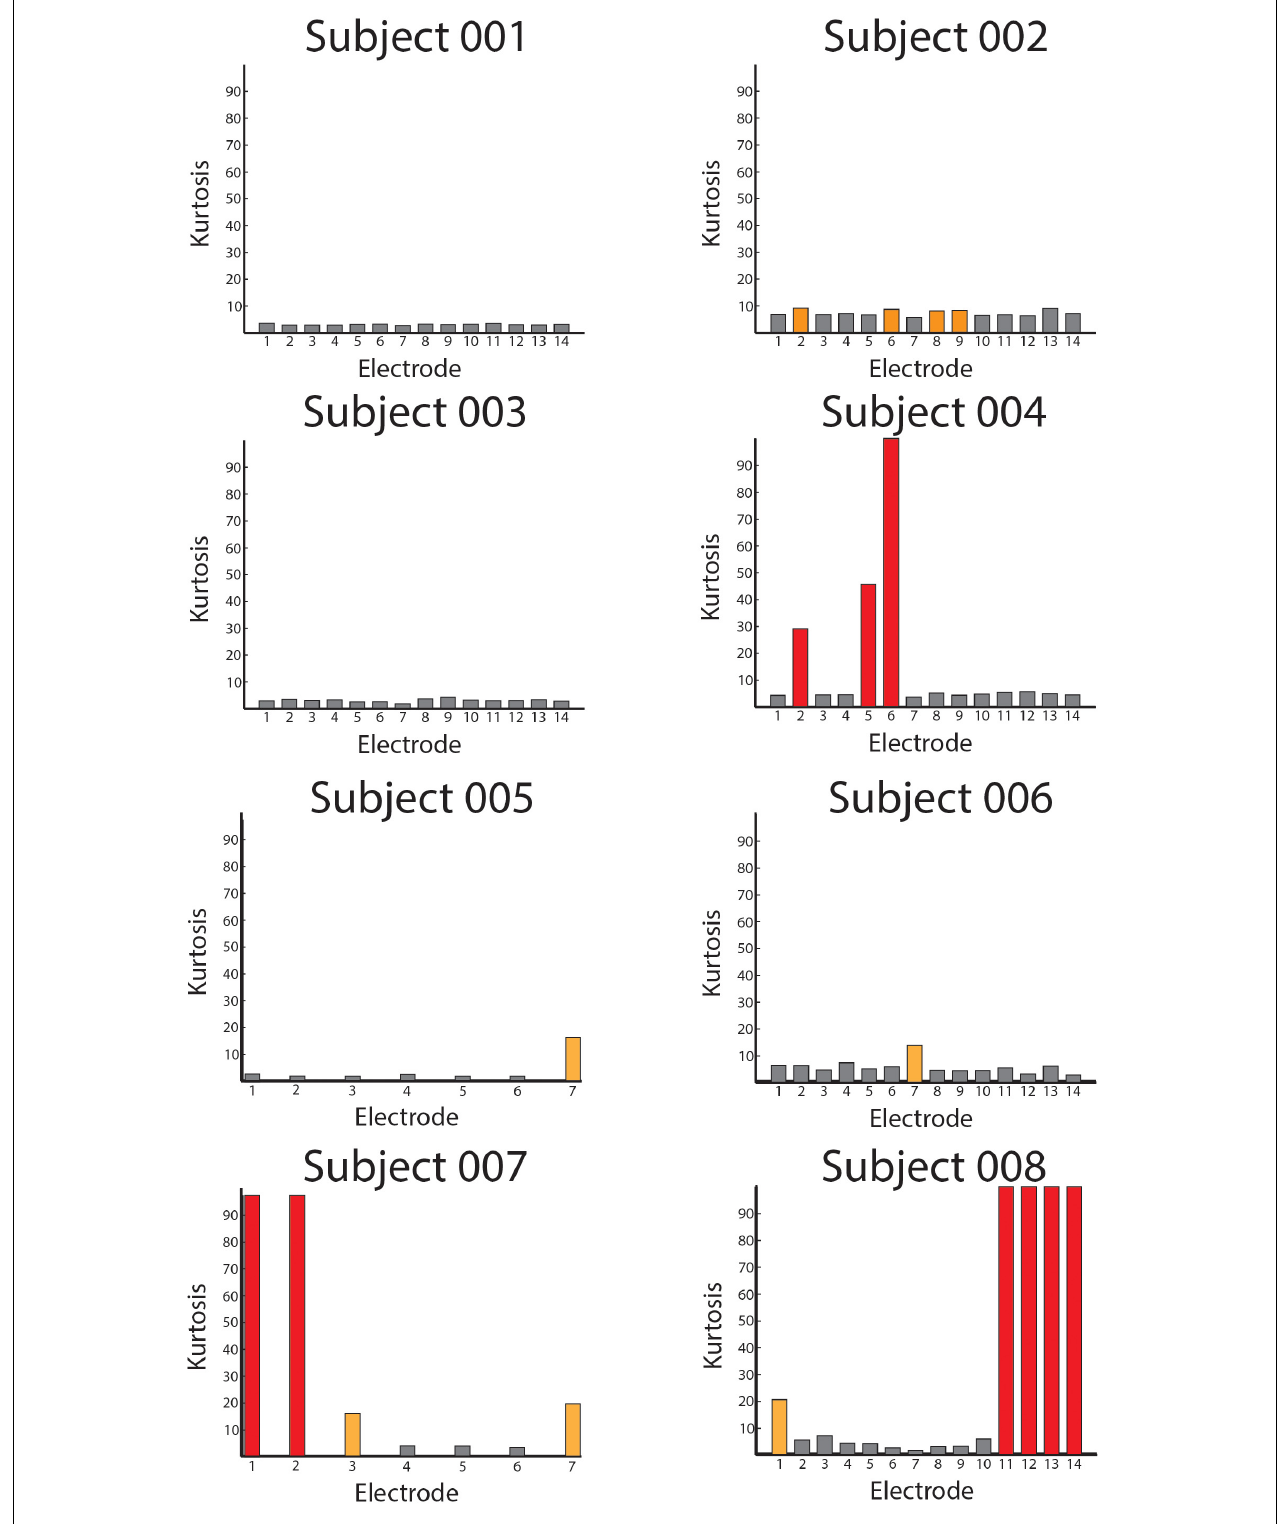
FIGURE 7 | Averaged Kurtosis values across bipolar recordings. The average Kurtosis value for each bipolar recording is shown for every patient in the database. The red bars indicate Kurtosis values that were not usable as the recordings were saturated by mechanical artifact, and the orange values represent borderline Kurtosis values ( > 10) that were also not used in